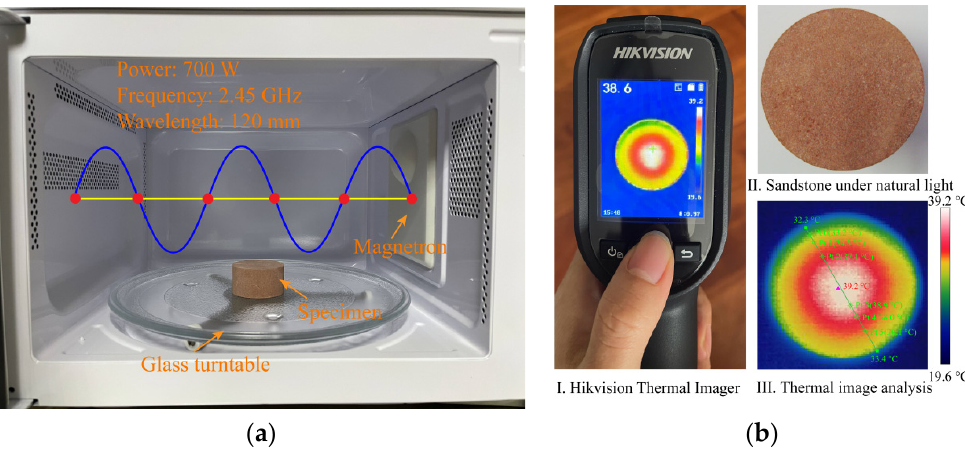
Figure 3. ( a ) microwave oven and ( b ) thermal analysis of sandstone.